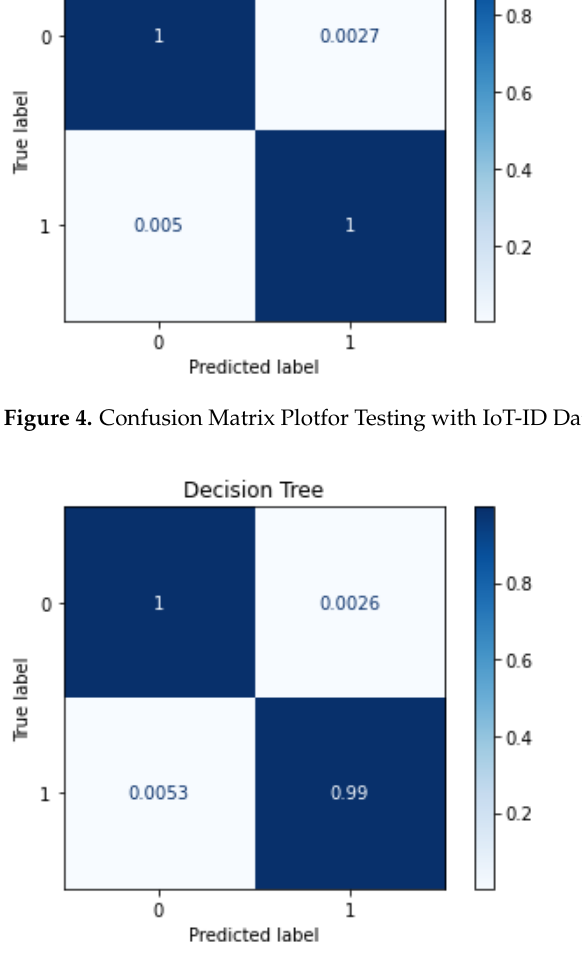
Figure 5. Confusion Matrix Plot for Testing with Aposemat IoT-23